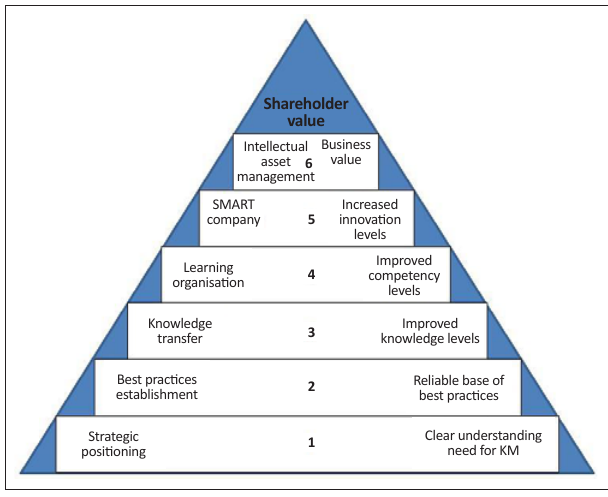
FIGURE 1: Pyramid of Excellence Framework and Maturity